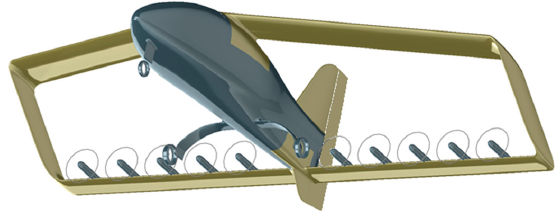
Figure 11. Concept of the inverted joined wing airplane with distributed propulsion.